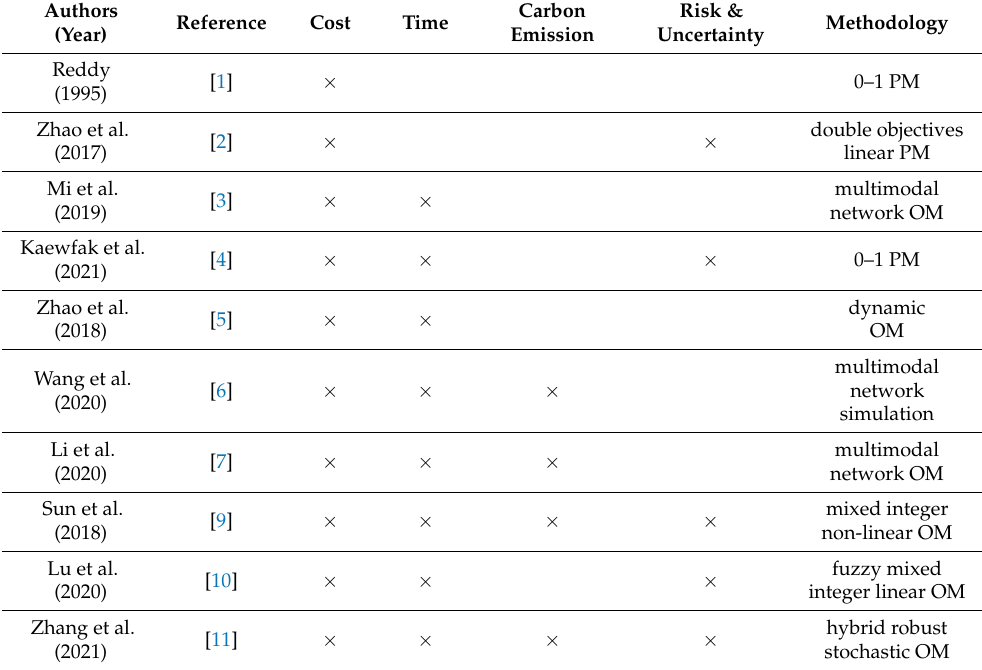
Table 1. Studies on multimodal transportation optimization